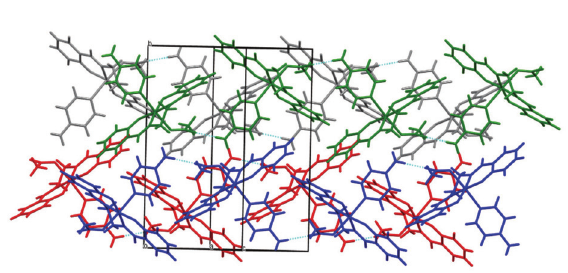
Figure 3. Packing view of compound 1 showing four symmetry re- lated infinite chains colored red, blue, green and